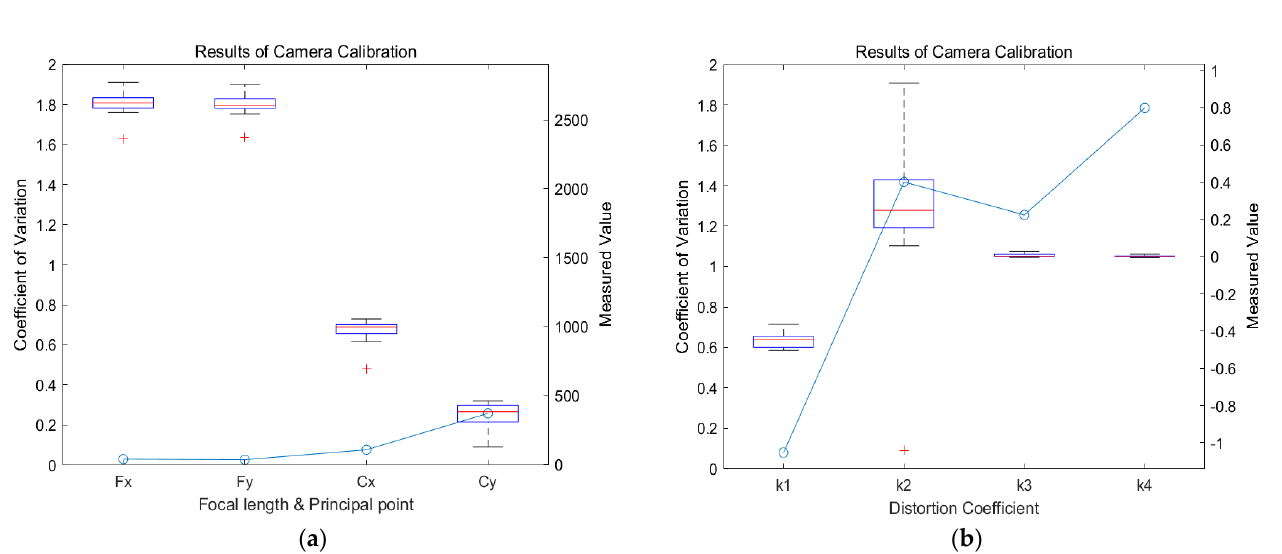
Figure 5. Box plot (( a ) parameters of the focal length and principal points, ( b ) parameters of the distortion) and coefficient of variation of the estimated intrinsic parameters of the vision sensor.